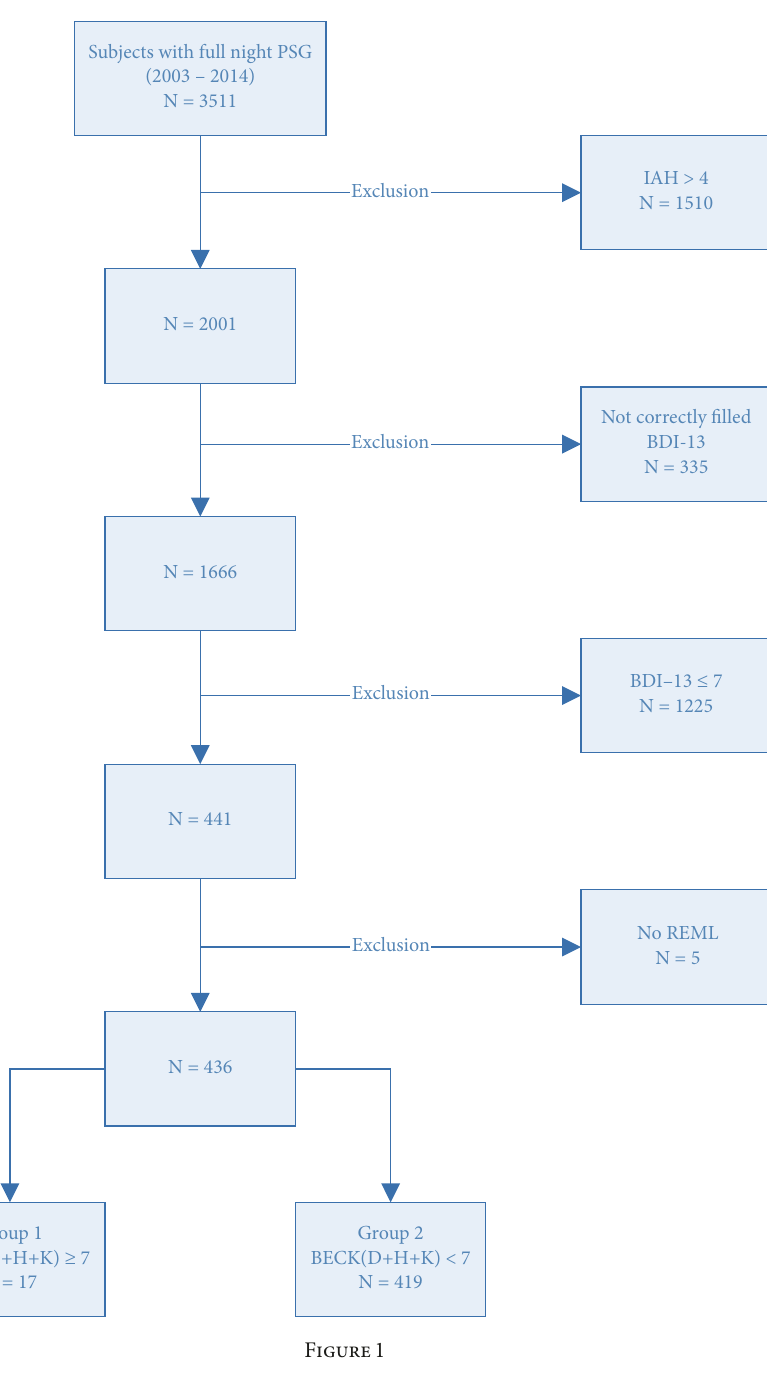
Age was controlled as another covariate and gender as a main factor. Indeed, according to Reynolds et al., significant age and gender effects are demonstrated for REML among other sleep variables